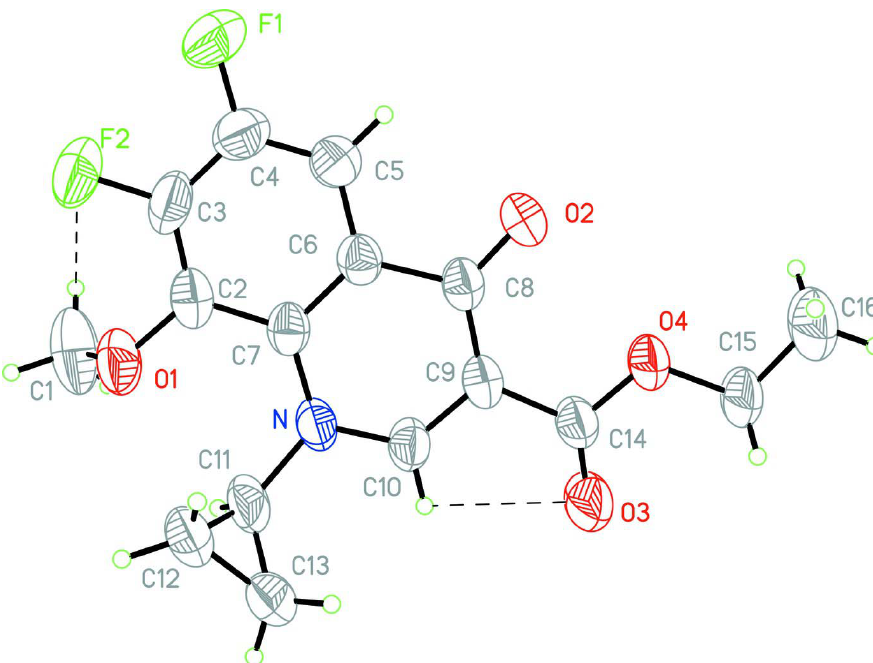
The molecular structure of the title compound, with the atom-numbering scheme. Displacement ellipsoids are drawn at the 30% probability